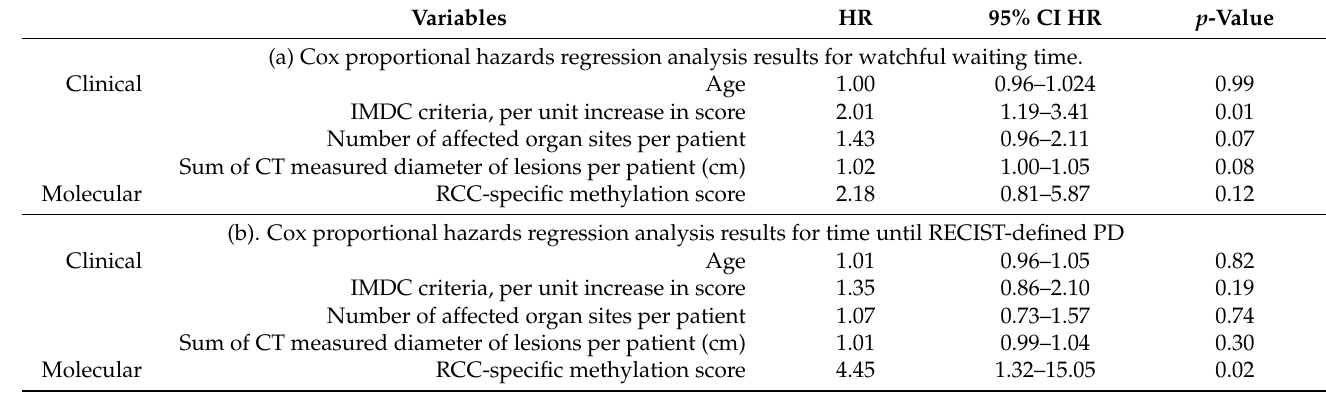
Table 2. Cox regression analysis. The tables were adopted from the main paper and updated according to the patients included within the biomarker analysis. The methylation scores resulting from the biomarker analysis were added as